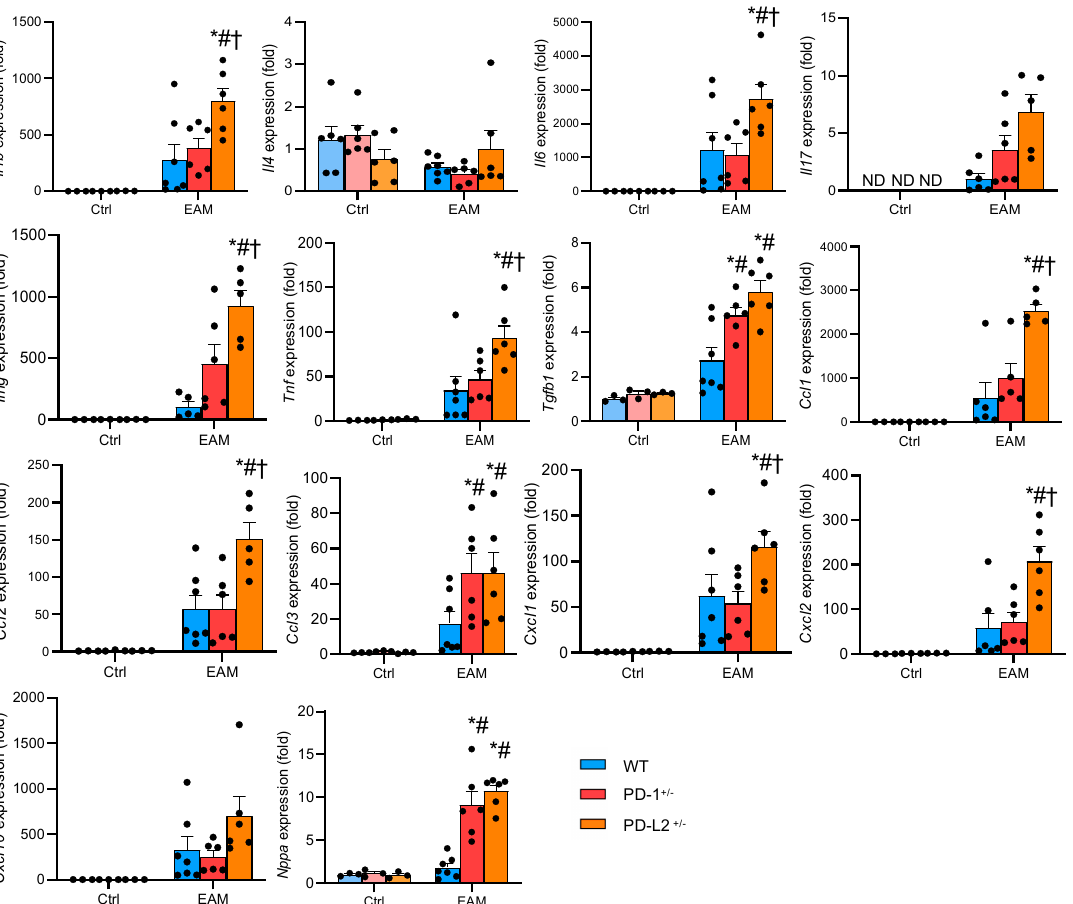
Figure 5. PD-L2 deficiency promotes proinflammatory cytokine expression in the experimental autoimmune myocarditis heart. mRNA expression of inflammatory markers in the hearts of wild-type (WT), PD-1 +/ − , and PD-L2 +/- mice at 14 days after immunization. Results are presented as the mean ± standard error of the mean. n = 3–6, * P < 0.05 vs. control, # P < 0.05 vs. WT, and † P < 0.05 vs. PD-1 +/ − .